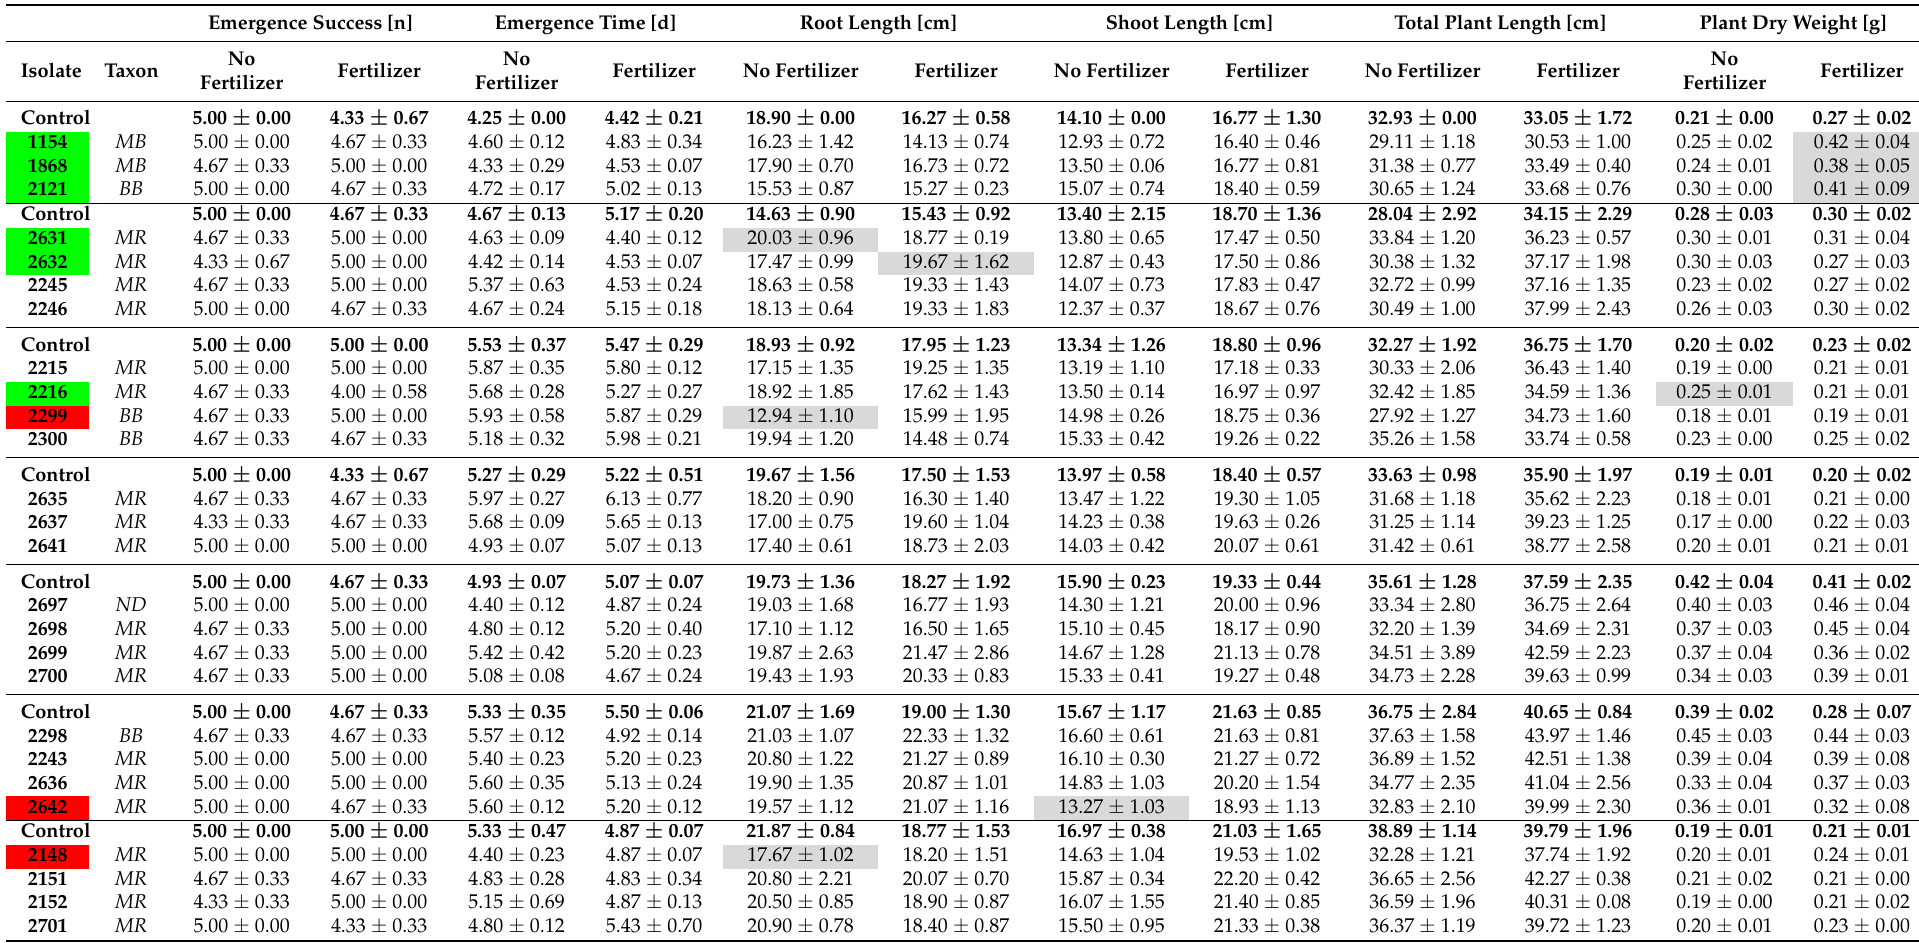
Table 3. Growth stimulating effects of selected fungal isolates on maize (Chapalu variety) grown in sand with/without fertilizer for 21 days. Data presented are the mean values ± SE (n = 15 (3 replicates with 5 seeds each)). Green fill indicates isolates with significant growth promoting properties, red fill indicates isolates with growth inhibitory properties and grey